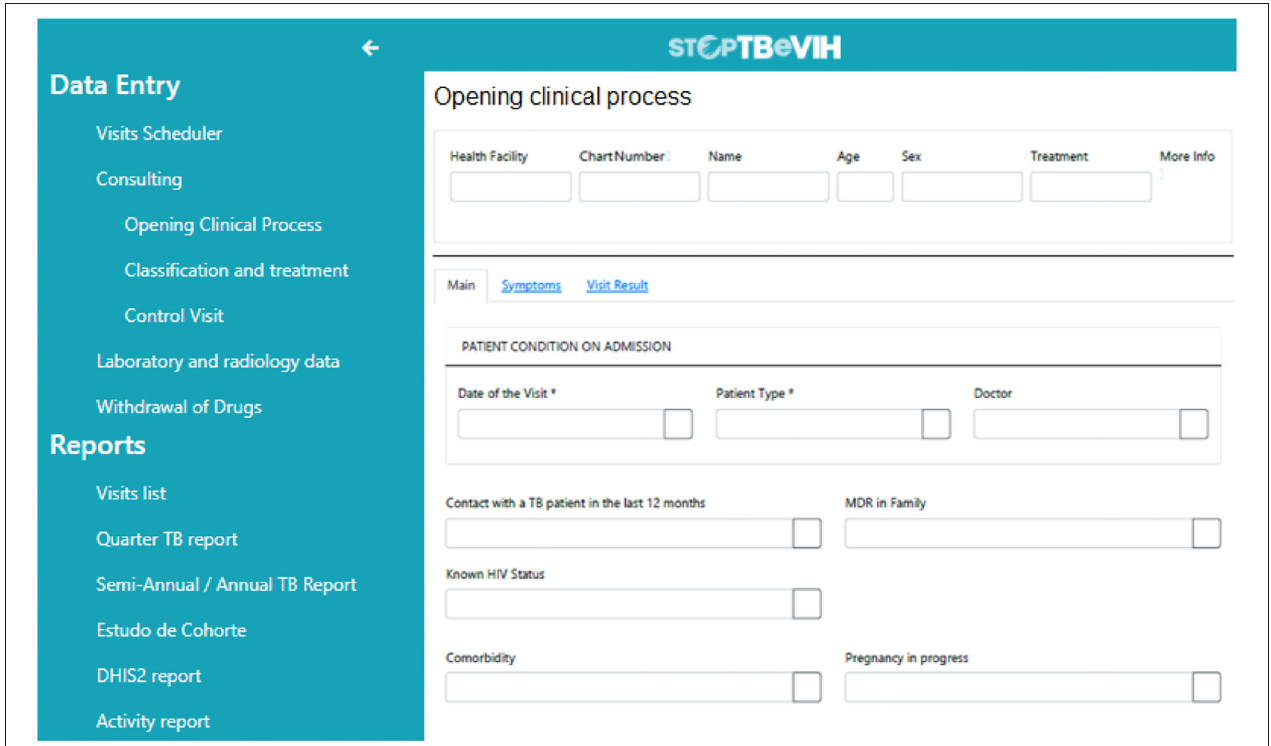
FIGURE 1 | EMR system print